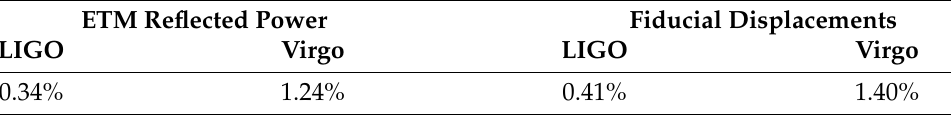
Table 1. Relative uncertainty estimates (1- σ ) for the laser power reflecting from the interferometer test mass, and for the Pcal-induced fiducial displacements, during the third observing run for both the LIGO [21] and the Virgo [46]